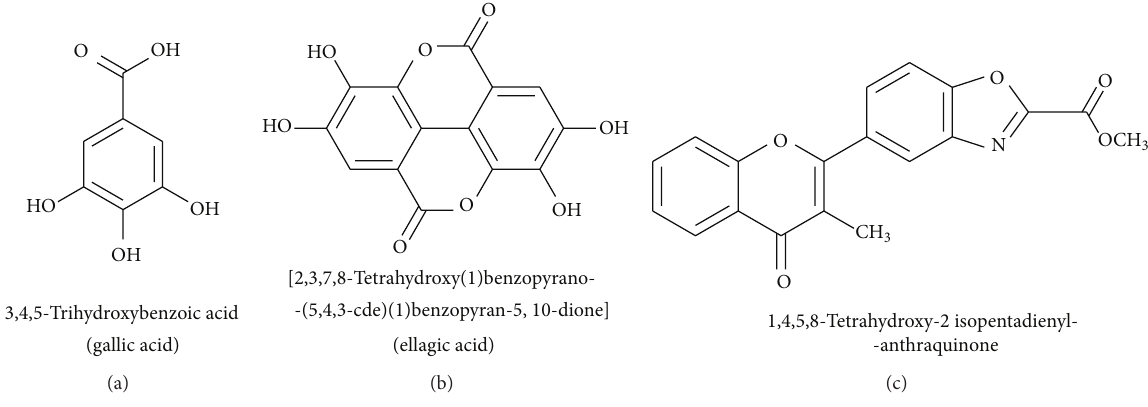
Figure 1: Basic molecular structure for the main components of the extracts.